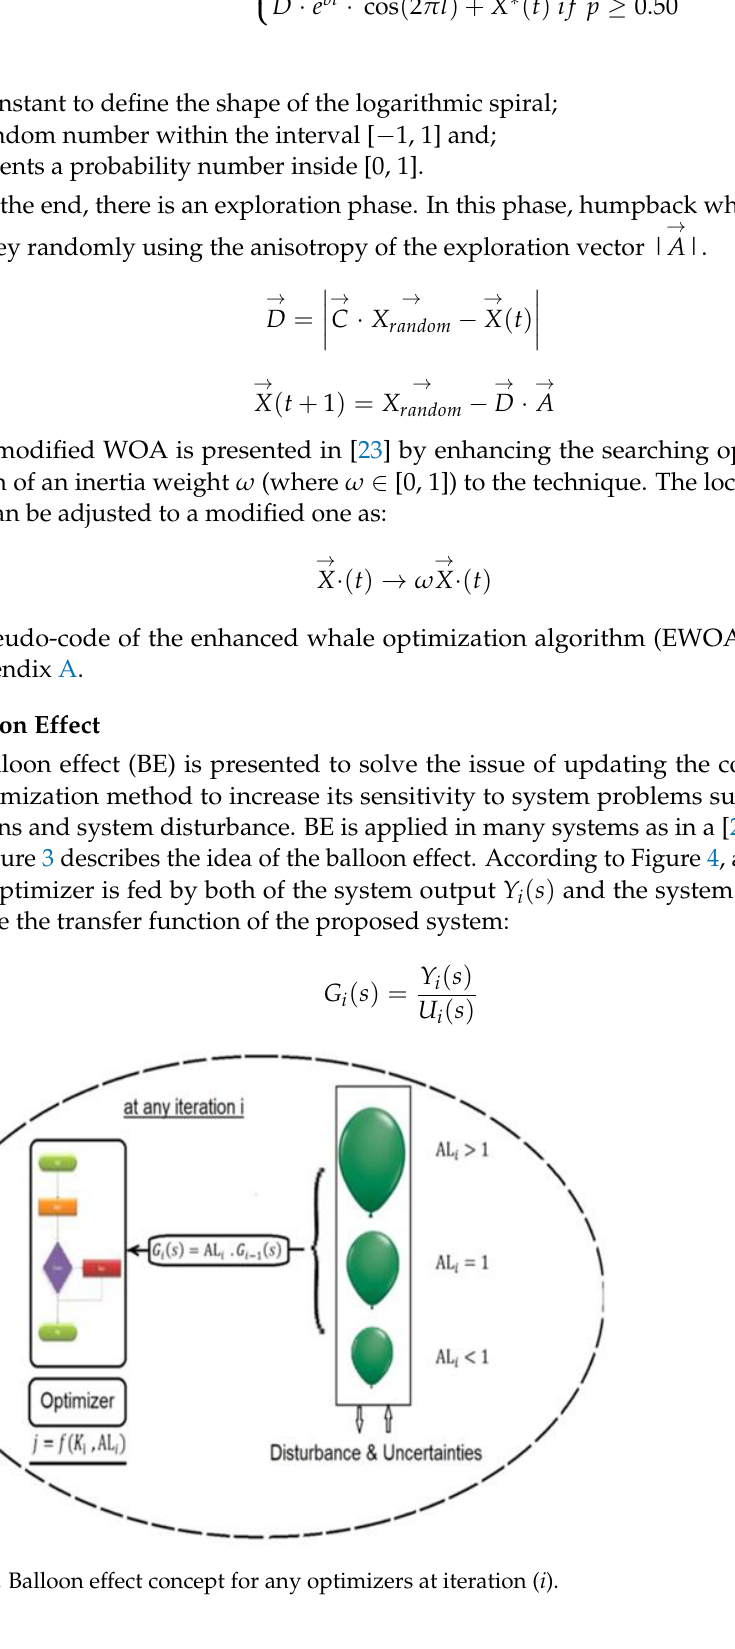
Figure 4. The overall temperature control system. 5. Proposed Control Technique The dependence of the objective function on nominal values of the system transfer function is considered as a foible in the adaptive control design using conventional EWOA, but the presence of BE beside EWOA deals with this disadvantage, where the objective function depends on the updated value of the transfer function at any moment. In this study, EWOA+BE is applied inside a temperature-adaptive controller of the electric furnace. For simplification, Equation (1) is used as a plant transfer function 𝐺 𝑜 (𝑠) and to make the total closed loop transfer function in the form of the second-order system the following lag compensator is applied: 𝐺 𝑐 (𝑠) = 𝐾 𝑖 (𝑠 + 0.24) 𝑠